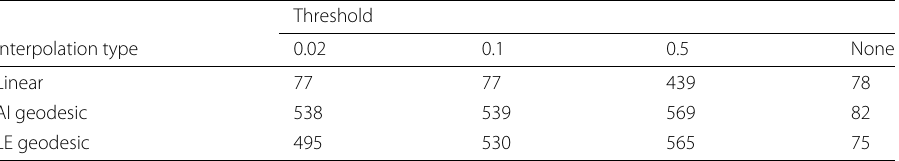
Table 2 Number of communities in average graph